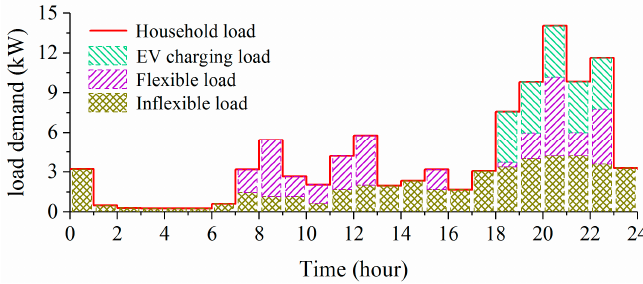
Figure 7. The 24-h load-demand profile for a household.